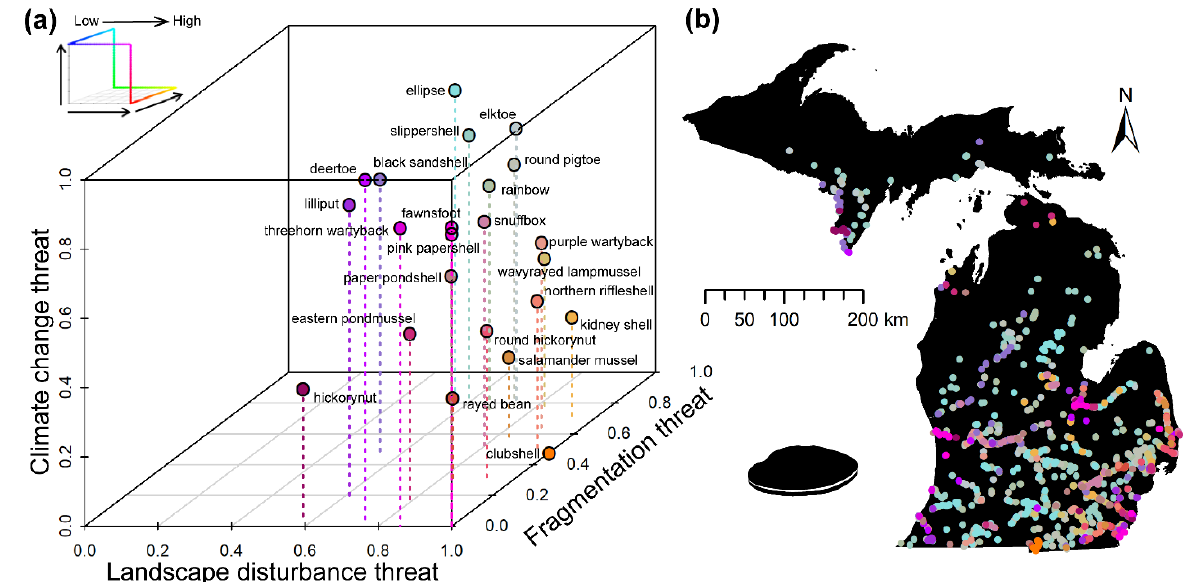
Figure 6. Threats to mussel species represented by three threat dimensions: climate change, human landscape disturbance, and fragmentation ( a ) and spatial distribution of known mussel occurrences ( b ) colored by composite threat through conversion of threat indices to the Red-Green-Blue (RGB) color system. Note, the study region is displayed in black in ( b ).